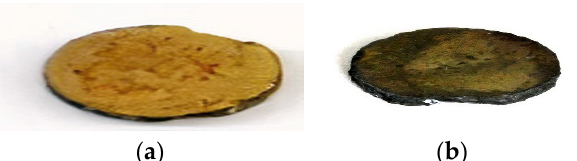
Figure 15. Bismuth titanate (BiTi) drop-in wafers. To the left in ( a ) is the pre-irradiated image and to the right in ( b ) is the post-irradiated bismuth titanate (BiTi) sample